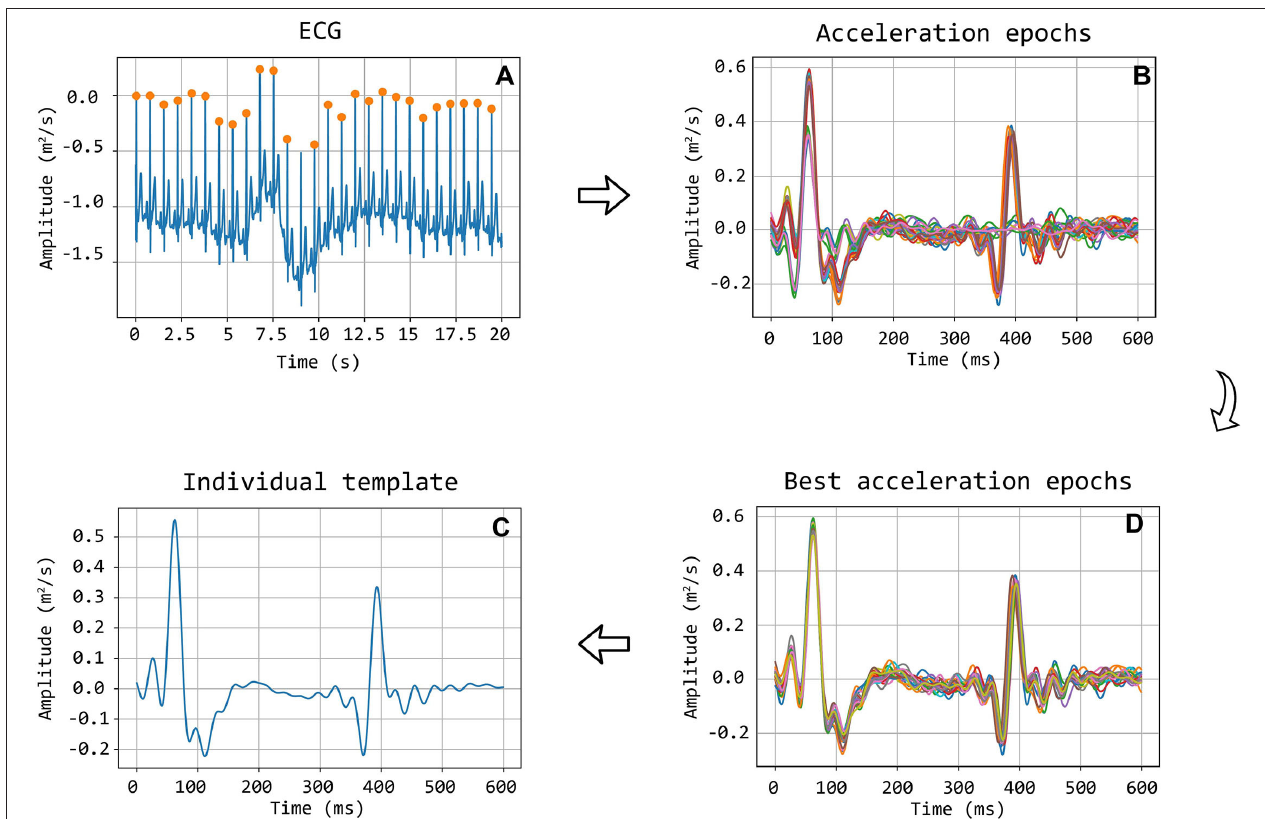
FIGURE 3 | Workflow detailing the construction of the template. Illustration of selection of good quality epochs using the correlation coefficient. (A) ECG signal with detected R peaks, which are used to segment the acceleration signal into heartbeat epochs (B) . After the correlation matrix analysis, only the good epochs are maintained (D) . In (C) the final individual template, calculated as the average of the good epochs, is